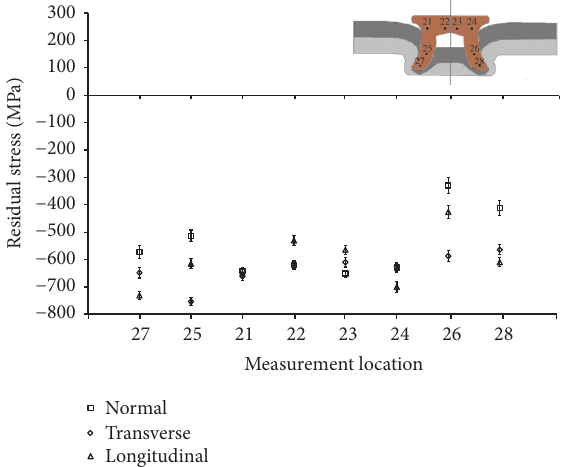
Figure 9: Distribution of residual stress in rivet for joint I of Table 1 (thin